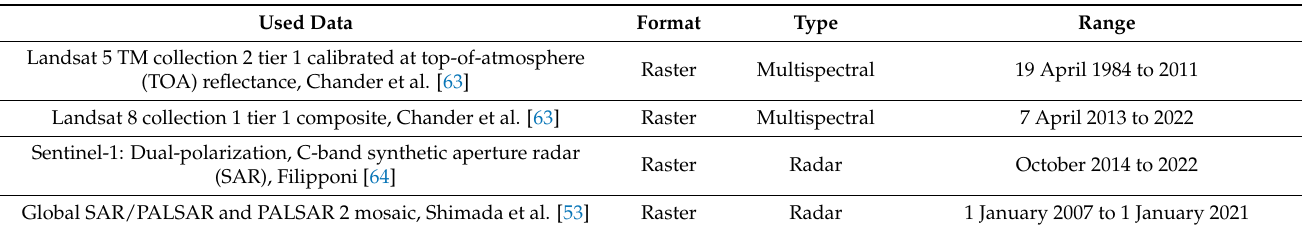
Table 3. Different input data sources used in this study with ranges and resolution.